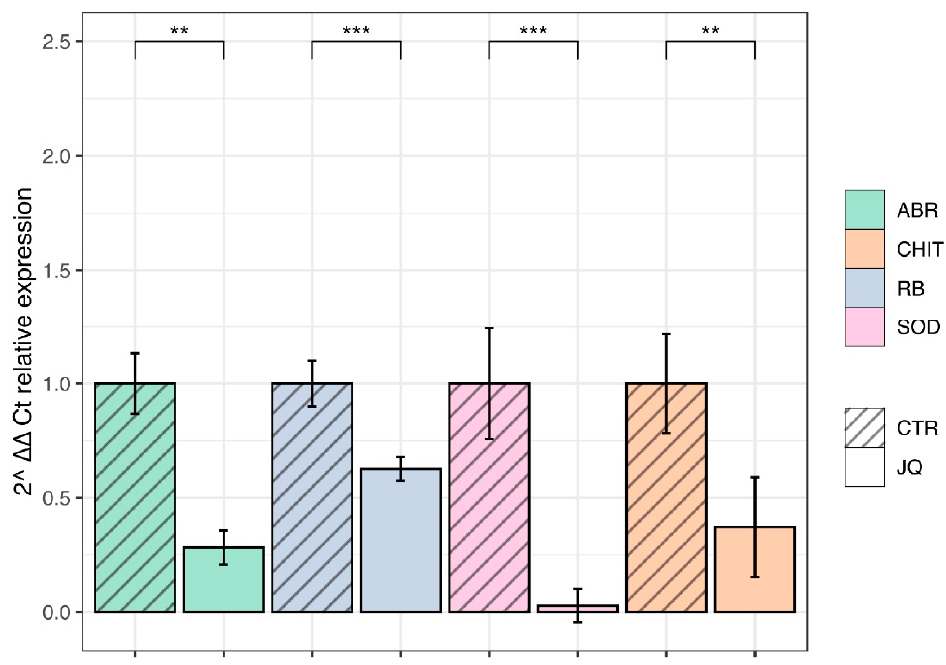
Figure 7. RT-PCR shows the mRNA of A. fumigatus expressions of ABR2 (ABR) , Chitinase (CHIT) , Ribonuclease (RB), and Superoxide dismutase (SOD) in the control (CTR) and JQ1-treated (JQ) groups. RT-PCR results show the normalized C T value of target genes after subtracting that of reference gene ( elongation factor -1). Unpaired Student t -tests to statistical analysis have been performed. ** p < 0.01; *** p < 0.001 compared to control.